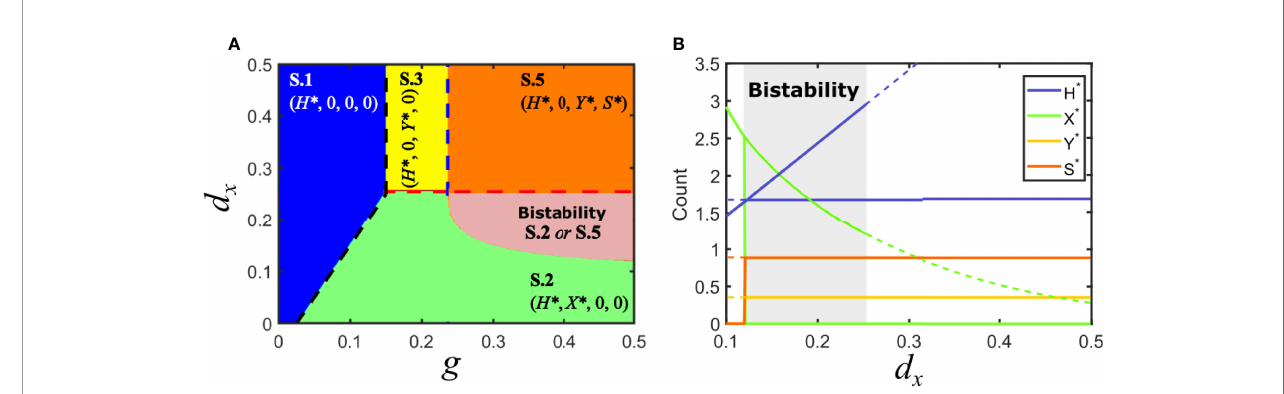
FIGURE 5 | Solutions for model S in parameter space: mutualistic satellite. (A) Phase space of solutions in the plane { g , d x } for a mutualistic satellite. Here, F c > F y . Some of the previous equilibrium solutions are maintained, as long as the inequalities that de fi ne them remain unchanged. However, a region of bistability appears, where solutions S.2 and S.5 are possible for the same parameters, depending on the initial conditions. (B) Bifurcation diagram of a cross section of A, for g = 0.5. As above, lines stand for the amount of each class at equilibrium. Dashed lines correspond to unstable solutions, while solid lines correspond to stable solutions. A region of bistability for 0.12 < d x <0.25 is shown in gray. A bifurcation where two solutions appear occurs at d x = 0.12 ; solutions collide with the degenerated solution S.4 and stability is modi fi ed at d x = 0.25. Note that we have represented simultaneously the two possible solutions in this plot, but only one of them occurs for given initial conditions, either S.2 or S.5 . The values of H *, Y * and S * do not depend on d x for S.5 . Parameters used: d =0.05, p x =0.1, p y =0.1, d y =0.25, p s =0.8, p sy =0.04, d s =0.3, p − y